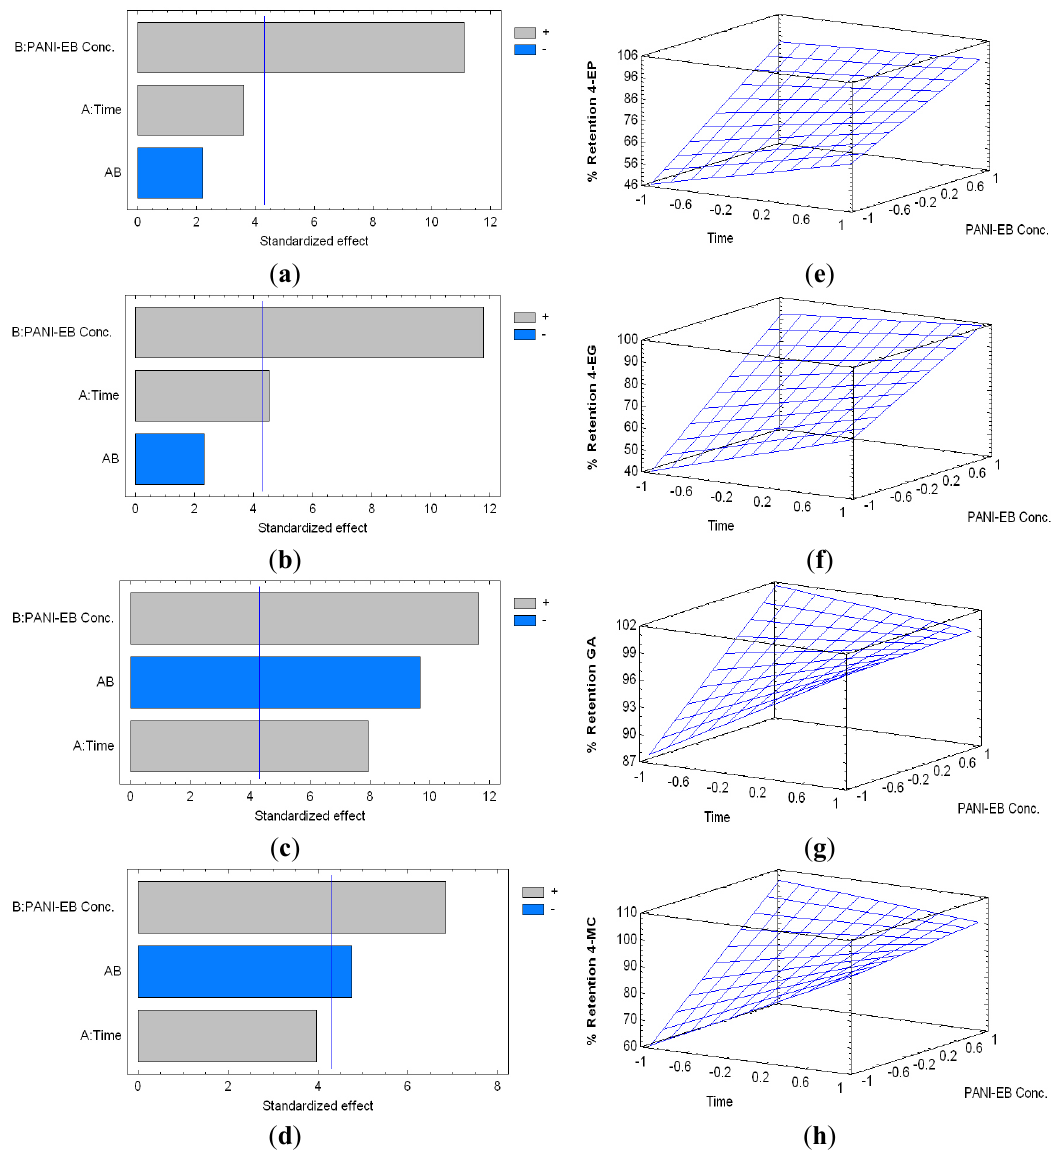
Figure 4. Standardized Pareto charts indicating the percentage of retention of 4-EP ( a ); 4-EG ( b ); gallic acid (GA) ( c ) and 4-methylcatechol (4-MC) ( d ); by PANI-EB treatment, respectively (Where: A, time of reaction; B, concentration of PANI-EB; and AB, interaction. The blue line represents the critical t -value, 95% confidence, with 10 total degrees of freedom); and estimated response surfaces of 4-EP ( e ); 4-EG ( f ); GA ( g ) and 4-MC ( h ) retention. The percentages of retention of all the compounds studied were mainly influenced by the PANI-EB concentration, which exerted a positive influence on their removal. The factor “time” exerted a positive,